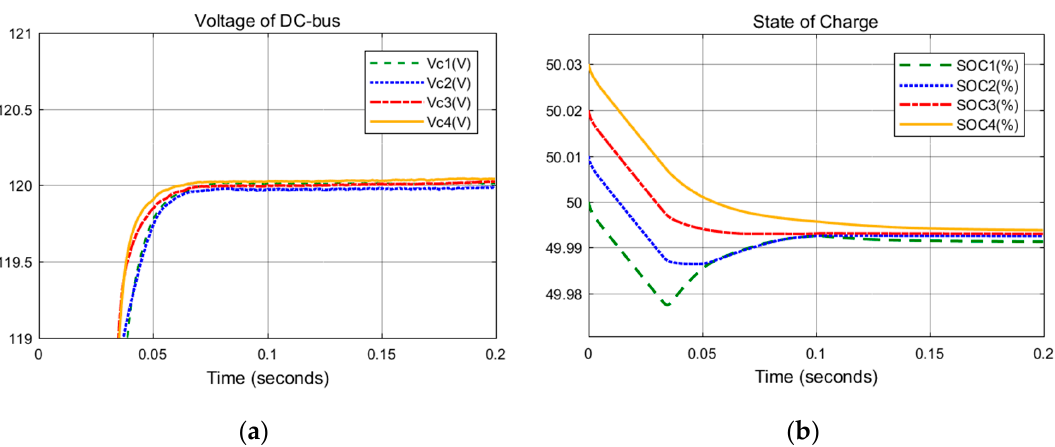
Figure 8. Only with the primary control of multiple DCESs: ( a ) DC-bus voltage; ( b ) battery SOC.